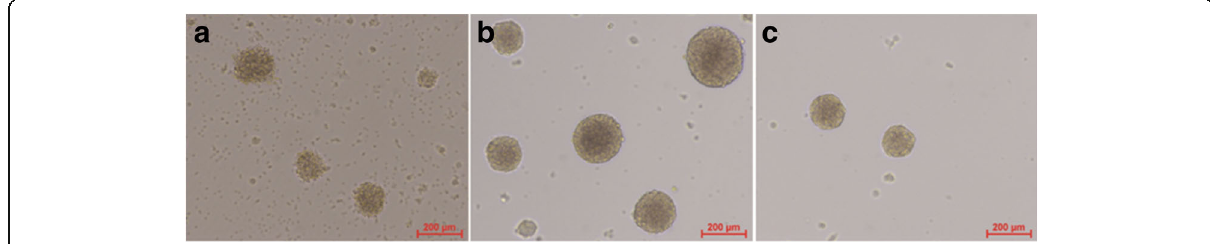
Fig. 1 Morphological characteristics of neural stem cells cultured at different time points. Isolated neural cells were cultured in neural stem cells medium, and morphological changes of the cells were observed under a microscopy. a Primary culture of neural stem cells at day 3. b Primary culture of neural stem cells at day 7. c Subculture of the day